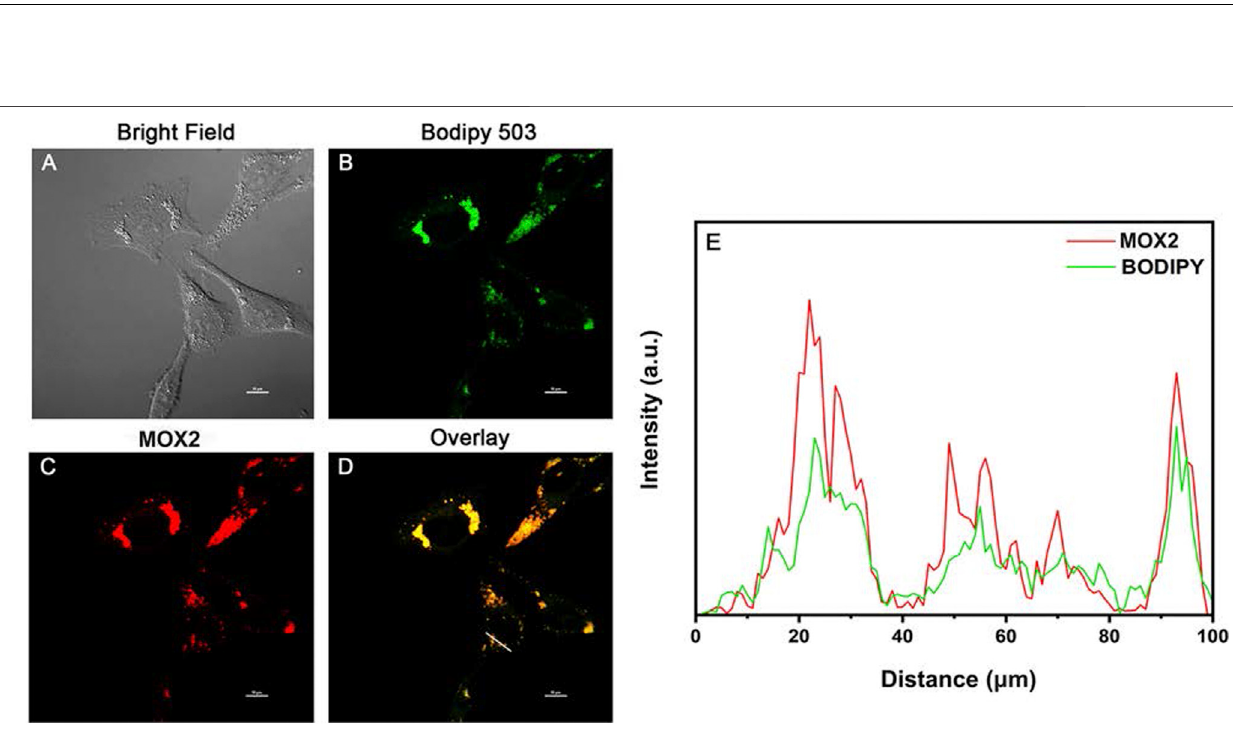
(cid:1) 488 nm; λ (cid:1) 600 – 640 nm); (D) overlayimage.Scalebar:10 µm. (E) Redandgreenlinesrepresent ex em